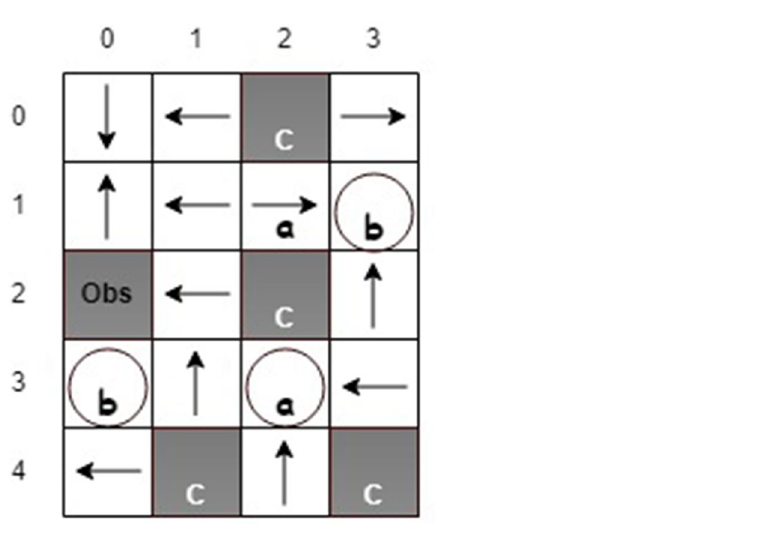
Figure 10. The generate optimal